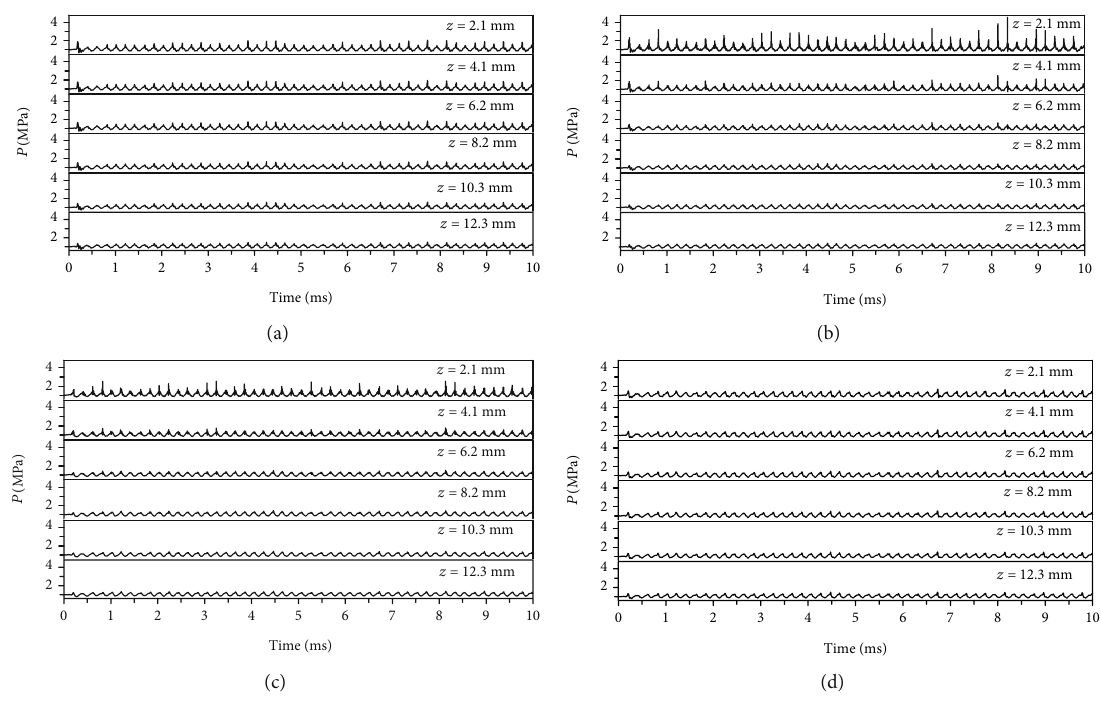
Figure 12: The time histories of pressure oscillations. (a) Slong line A. (b) Along line B. (c) Along line C. (d) Along line